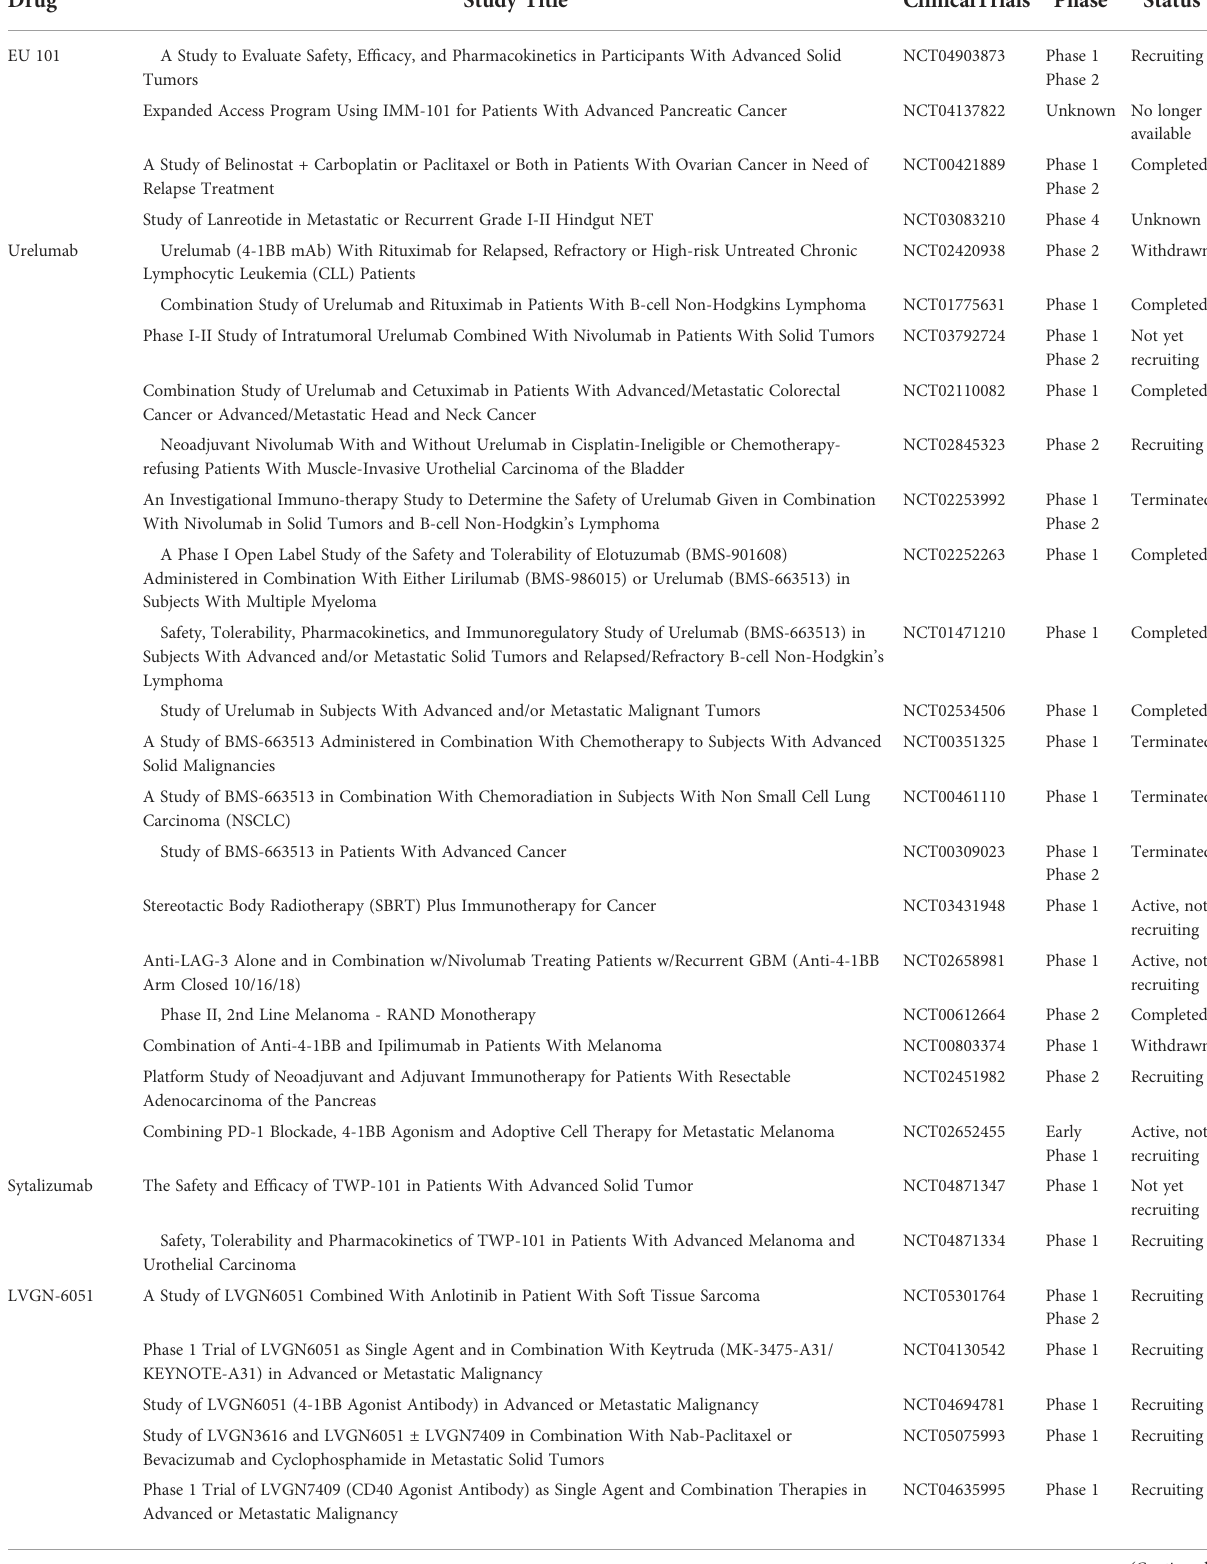
TABLE 1 4-1BB modulators in clinical